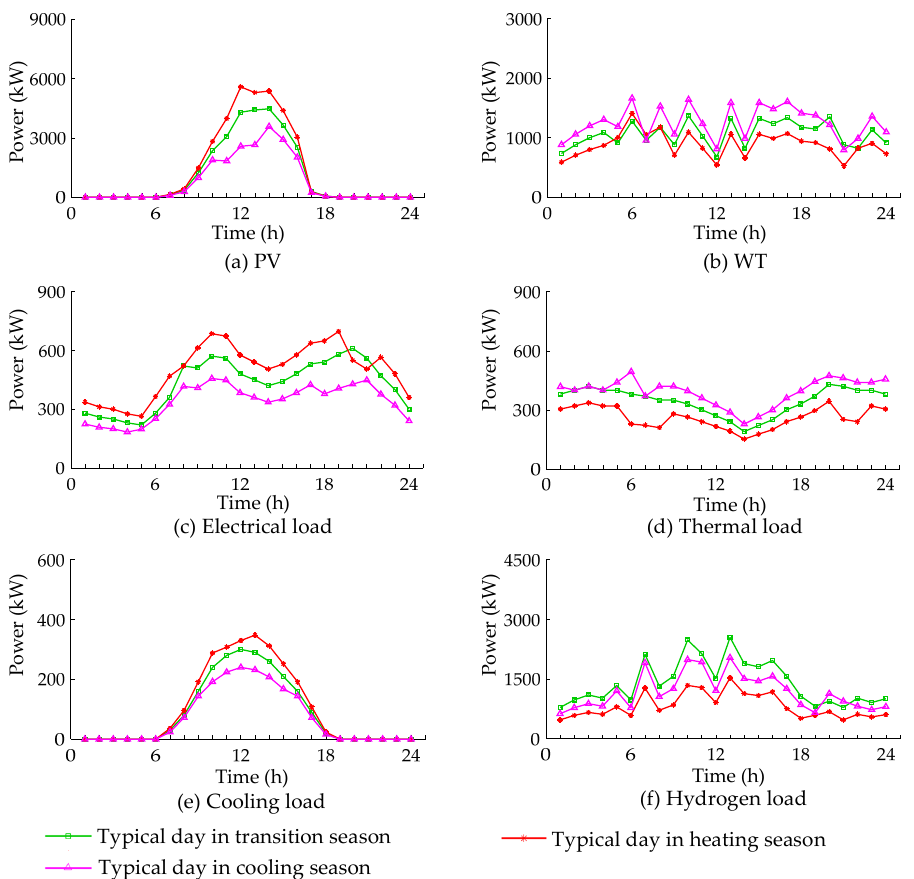
Figure 5. Renewable energy generation and load demands in a typical day for DES 0.